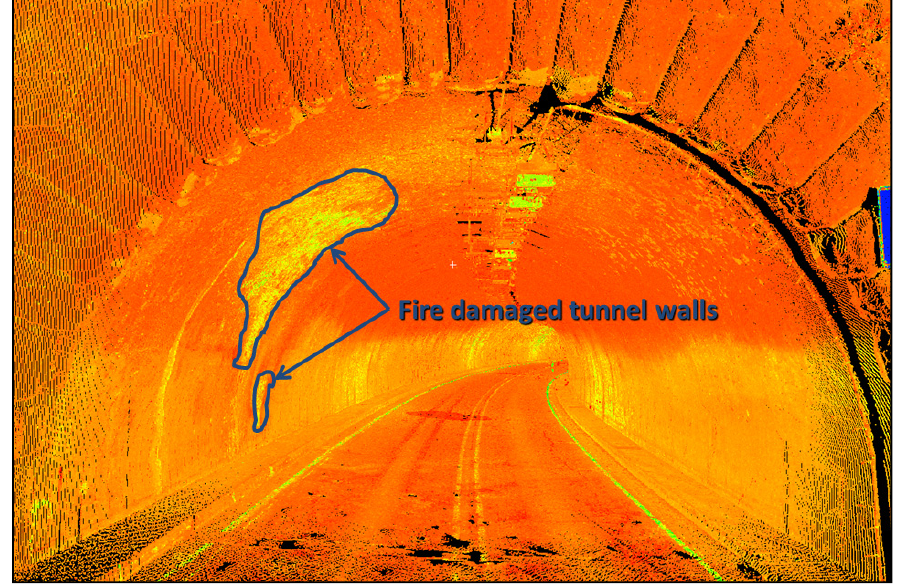
Figure 12. Close examination of the intensity shaded point cloud (static scan) shows additional, minor damage to concrete in a tunnel in Oregon (Courtesy of Oregon